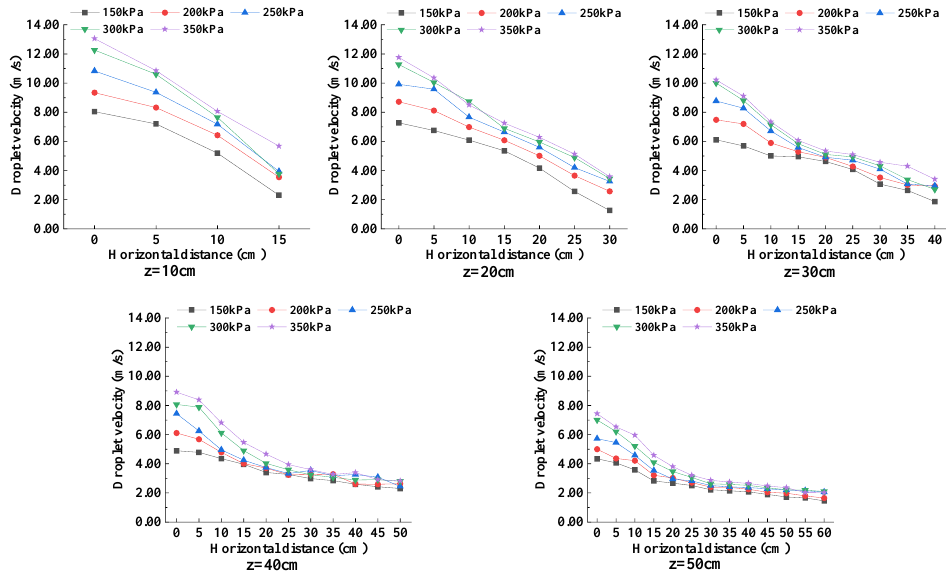
Figure 9. Horizontal direction droplet velocity V X distribution in different pressure. The distribution of droplet velocity V X on the X axis of the adjuvants is shown in Figure 10, the droplet velocity V X decreases with the increase of the horizontal distance. The velocity V X of Maisi adjuvants is the largest in the horizontal direction, followed by the Surun and the Maidao, and the smallest is AdseeAB-600. Because Maisi is a vegetable oil adjuvant can produce stable emulsion droplets, reduce the concentration of surfactant on the oil-water interface, resulting in increased hydrophobicity, hydrophobic points form holes, compared with organic silicon and cationic surfactants, the penetration ability is weak, and the droplets are broken and fast. In the spray area, the droplets exchange en- ergy with the surrounding air in the process of movement, and a part of the air is entrained to move in the same direction, forming a two-phase flow of gas-liquid mixture. The drop- lets near the center of the nozzle are concentrated. When the droplets move, the airflow forms vortex at the tail of the nozzle, and the droplet velocity decreases significantly under the influence of air power. Near the edge, the number of droplets is rare, and the condi- tions for reducing velocity change are few.